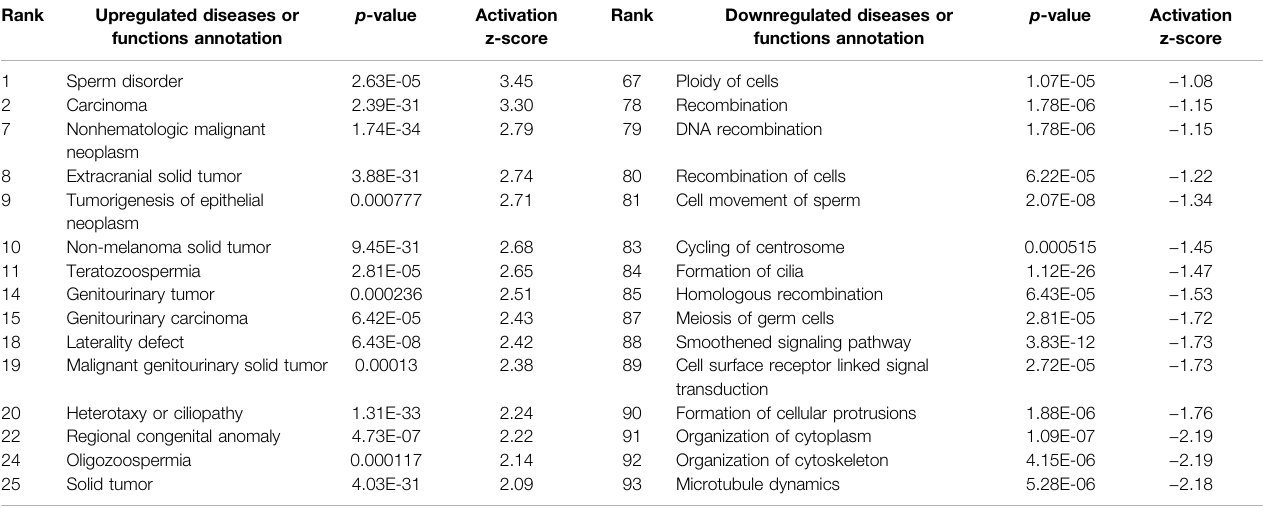
TABLE 7 | Ingenuity Pathway Analysis table of disease and Biological Functions from TPxCP DEGs ( p < 0.01, log fold change > 1/ < − 1). From “ Diseases or Functions Annotation ’’ column, after removing any redundancies, functions without a z-score, or a z-score between − 1 and 1. Mapped IDs: 4,926; unmapped IDs: 1,921 (raw data), after settings of logFC > 1 or < − 1/ p < 0.01.696 analysis-ready molecules: 89 upregulated and 607 downregulated. Ranked by z-score. Left: upregulated pathways. Right: downregulated pathways.